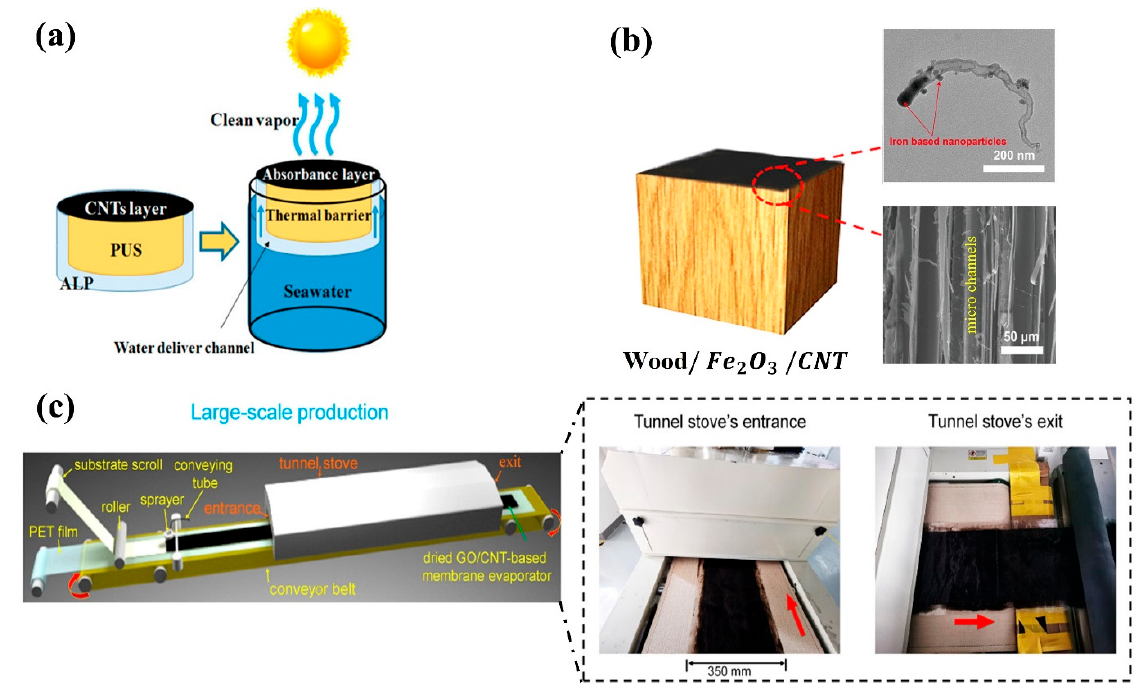
Figure 5. ( a ) Schematic of a solar thermal water purification system using a CNT-based floating solar still to collect high solar energy, PUS as a thermal isolator to preserve heat, and air-laid paper as a water transport channel to filter saltwater (reproduced with permission, Copyright 2019 American Chemical Society [62]. ( b ) Photograph and example of the use of capillary channels to reduce heat loss (reproduced with permission, Copyright 2021 American Chemical Society [67]). ( c ) Large-scale production of GO/CNTs as a solar absorber for solar thermal water purification (reproduced with permission, Copyright 2022 American Chemical Society [46]).